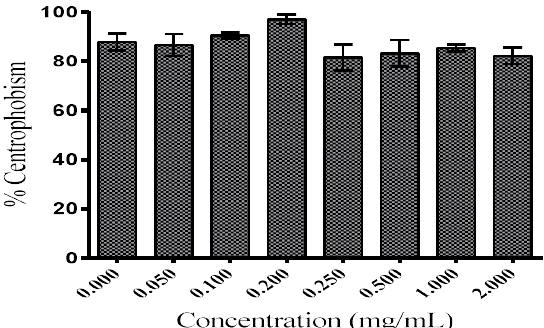
Figure 4. Percentage (%) of centrophobism of the Drosophila melanogaster in the open field test. The values are expressed as means ± S.E.M ( n = 3) as calculated by one-way ANOVA followed by Tukey’s multiple comparisons test with a single pooled variance ( p < 0.05). No significant differences between concentrations.